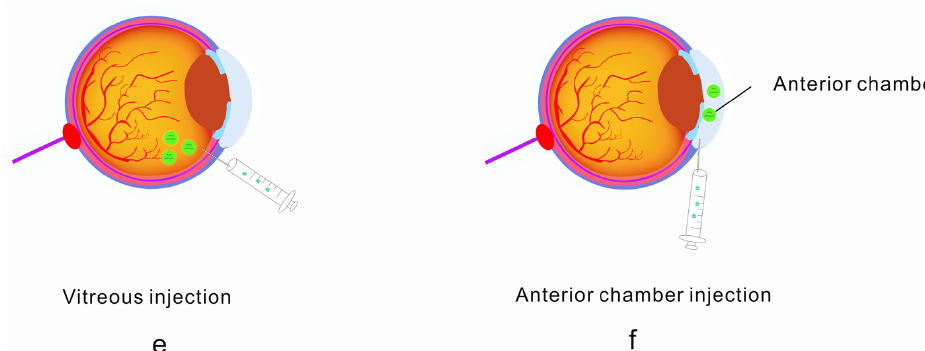
Figure 2. Standard implantable administration modes: subretinal injection, conjunctival injection, vitreous injection and anterior chamber injection [56,57]. ( a ) Retroscleral route—injected into the retina; ( b ) corneal injection into the subretina; ( c ) conjunctival injection using the pars plana route into the retina; ( d ) conjunctival injection; ( e ) vitreous injection; ( f ) anterior chamber injection.